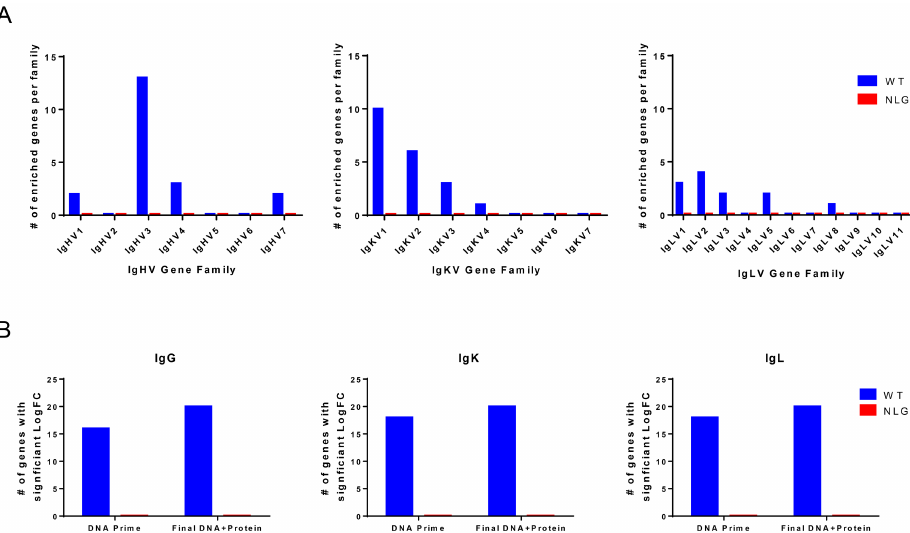
immunization groups. Positive LogFC was calculated and compiled between the pre-immunization and post DNA/ Protein Boost 2 for IgHV (left) ,IgKV (middle) , and IgLV (right) gene families. All LogFC have a false discovery rate of < 0.05. (B) Total number of V genes with a positive LogFC and FDR < 0.05 for WT and NLGS-3 Core immunization groups between pre-immunization and post DNA Prime or post DNA/Protein Boost 2 for IgHV (left) ,IgKV (middle) , and IgLV (right) V alleles. Bars in A and B represent the total number of genes with significant LogFC. Bars at baseline indicate no genes scored a significant